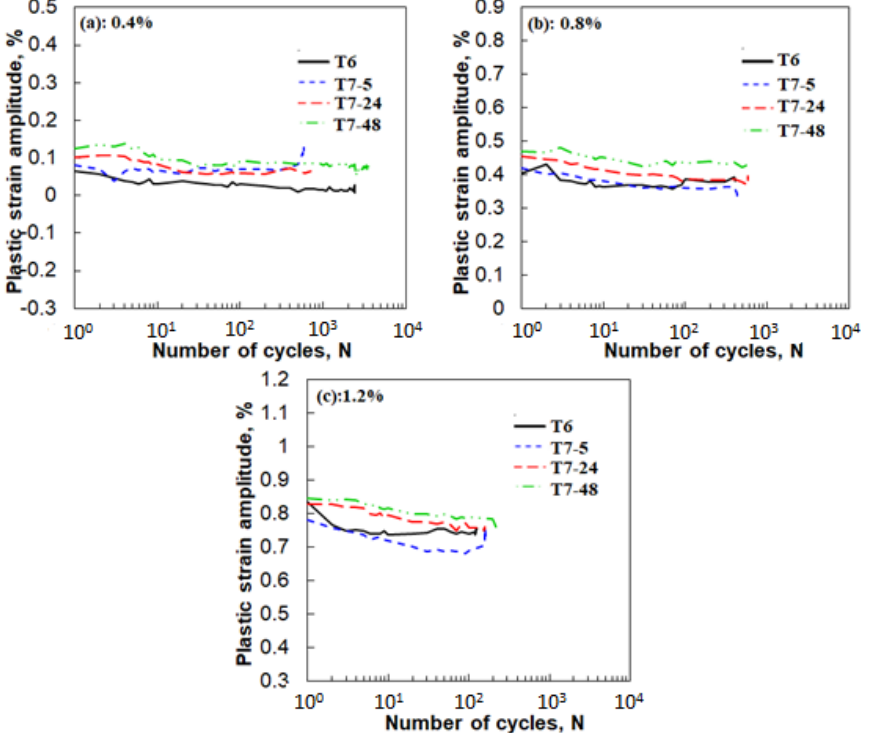
Figure 8. Plastic strain amplitude vs. the number of cycles under various aging conditions tested at various strain amplitudes of ( a ) 0.4%, ( b ) 0.8%, and ( c ) 1.2%.